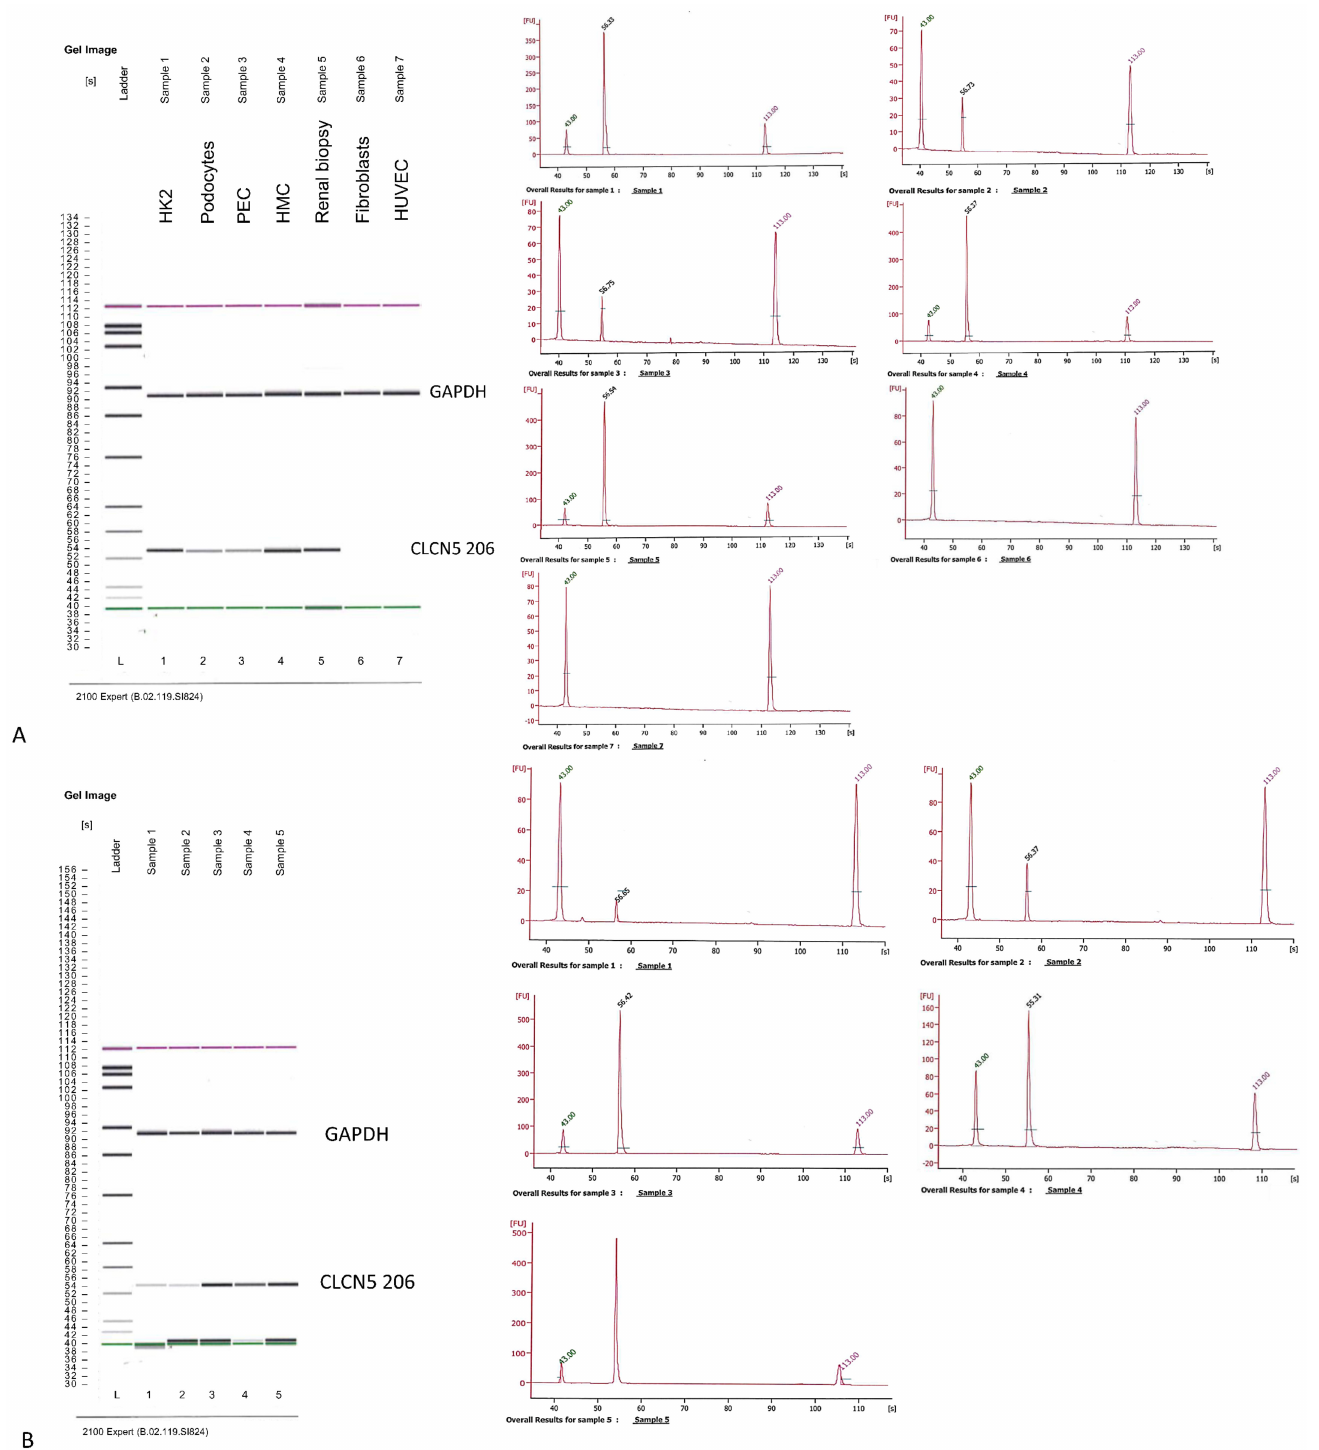
Figure 4. Qualitative RT-PCR analysis of CLCN5 -206 isoform mRNA. Images generated by Agilent 2100 bioanalyzer of amplified housekeeping gene (glyceraldehyde 3-phosphate dehydrogenase— GAPDH ) and CLCN5 -206 isoform in ( A ) different human kidney cell lines, and ( B ) in CLCN5 − / − (Lines 1 and 2) and WT clones (Lines 3, 4, and 5). Chromatograms refer to CLCN5 -206 isoform amplicons. Images are representative of three independent